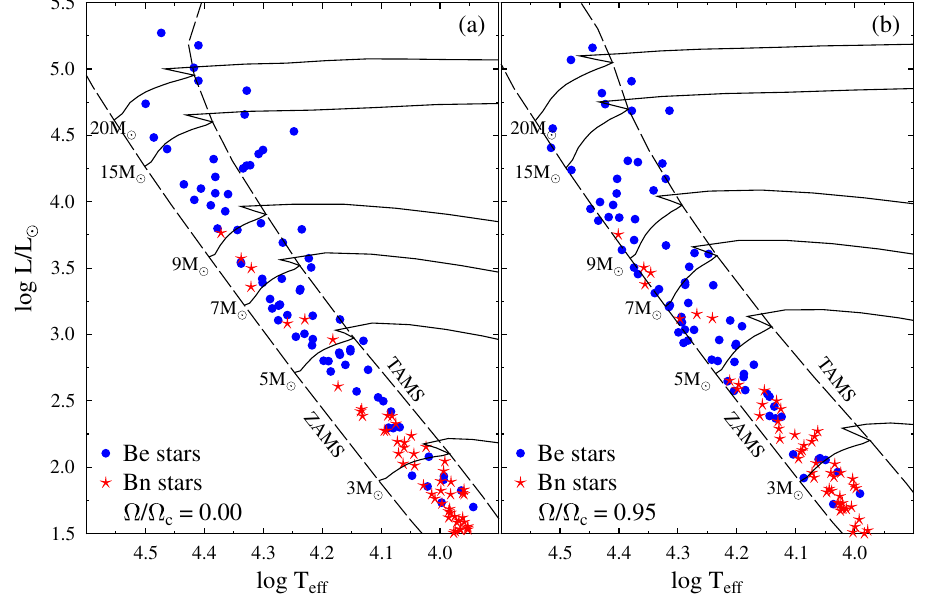
Figure 37. Panel a : Hertzsprung–Russell diagram of Be (blue points) and Bn stars (red stars) studied by Cochetti et al. [146] where ( logL / L (cid:12) , T eff ) are not treated for rotational effects. Panel b : same as in Panel a, but parameters are corrected for rotational effects, assuming that for all stars, it is Ω / Ω c = 0.95. The evolutionary tracks are from Ekström et al. [145] without rotation (Panel a ), and with rotation (Panel b ) where Vo = 300 kms − 1 in the ZAMS. Adapted from Cochetti et al. [146]. Another way of presenting the evolutionary stage of Bn and Be stars is using masses and fractional ages ( M / M (cid:12) , t / t MS ), as shown in diagrams of Figure 38. In Figure 38a,b parameters ( M / M (cid:12) , t / t MS ) are plotted without and with correction for rotation effects, respectively. Figure 38c,d are zooms of Figure 38a,b for masses M / M (cid:12) (cid:46) 10, respectively, in order to better see the behavior of Bn stars (red stars) from that of Be stars (blue points). These ( M / M (cid:12) , t / t MS ) diagrams suggest that Bn stars seem to fill up an apparent gap of Be stars nested in the mass range 2 (cid:46) M / M (cid:46) 4, which encompasses a more or less large evolutionary span. When rotational effects are not accounted for, Be and Bn stars are likely located in the second half of the MS. Otherwise, corrections carried on the estimates of ( M / M (cid:12) , t / t MS ) for rotational effects considering Ω / Ω c = 0.95, Be stars are redistributed from the ZAMS to the TAMS, while Bn are scattered over a rather large evolutionary time interval downwards to the